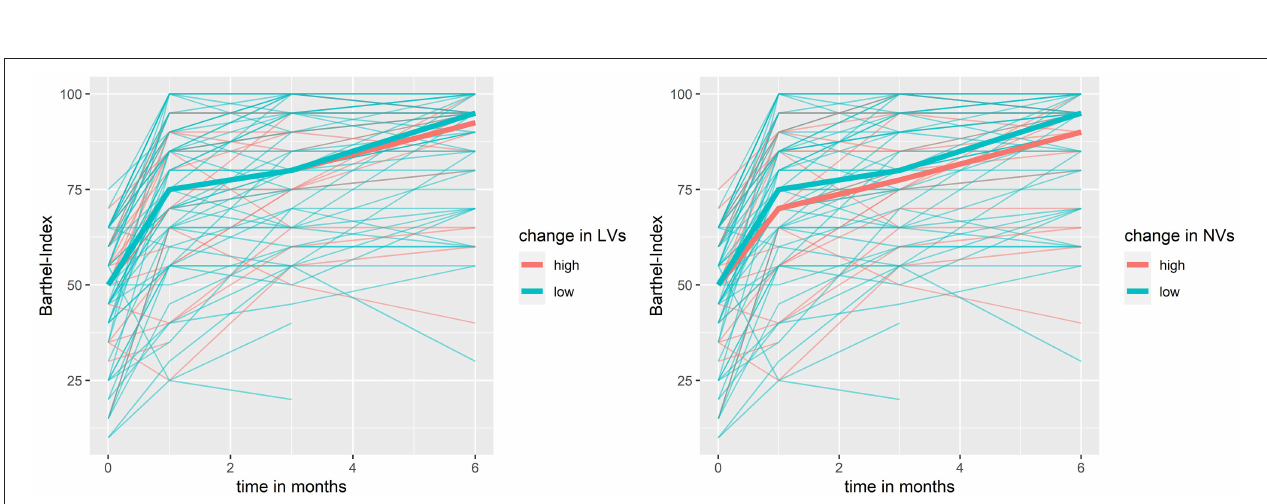
FIGURE 4 | Barthel-Index in the first 6 months post stroke by dynamic in neuronal- and leukocyte-derived extracellular vesicles. bold line = median; NV, neuronal-derived vesicles; LV, leukocyte-derived